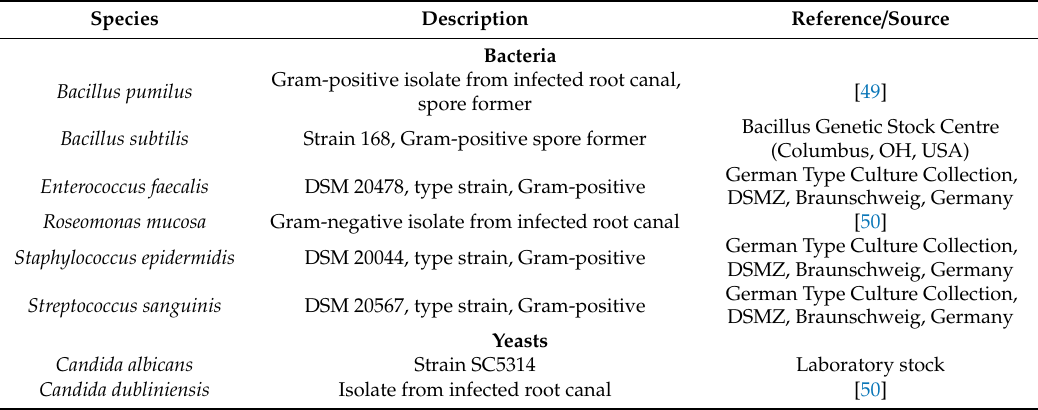
Table 1. Microorganisms used in this